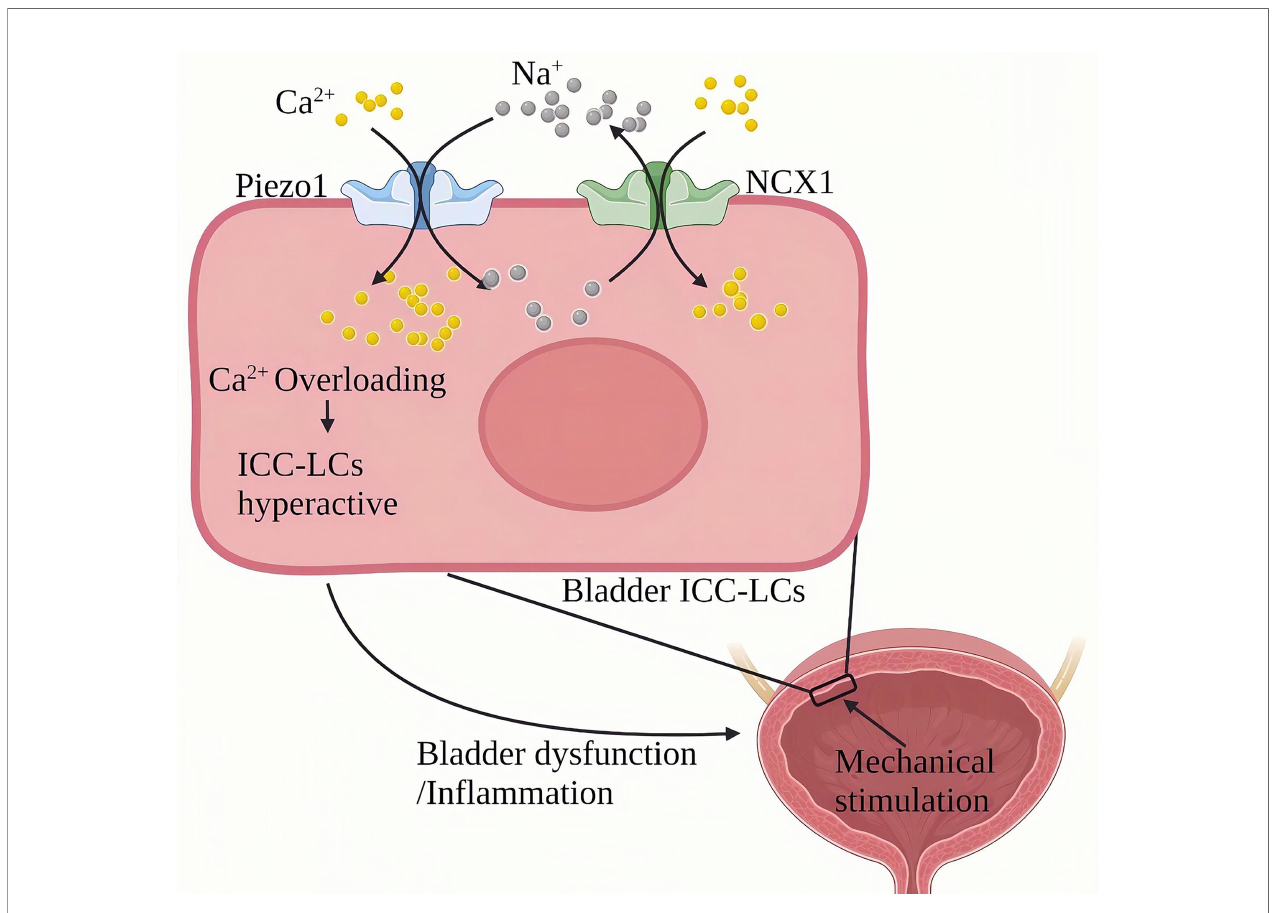
FIGURE 11 | Schematic diagram of the role of Piezo1 in chronic bladder in fl ammation. The ICC-LC in the bladder senses mechanical stimulation and works in reverse with NCX to trigger the continuous fl ow of Ca 2+ into the ICC-LC, leading to Ca 2+ overload and ICC-LC dysfunction and inducing bladder function abnormalities and in fl